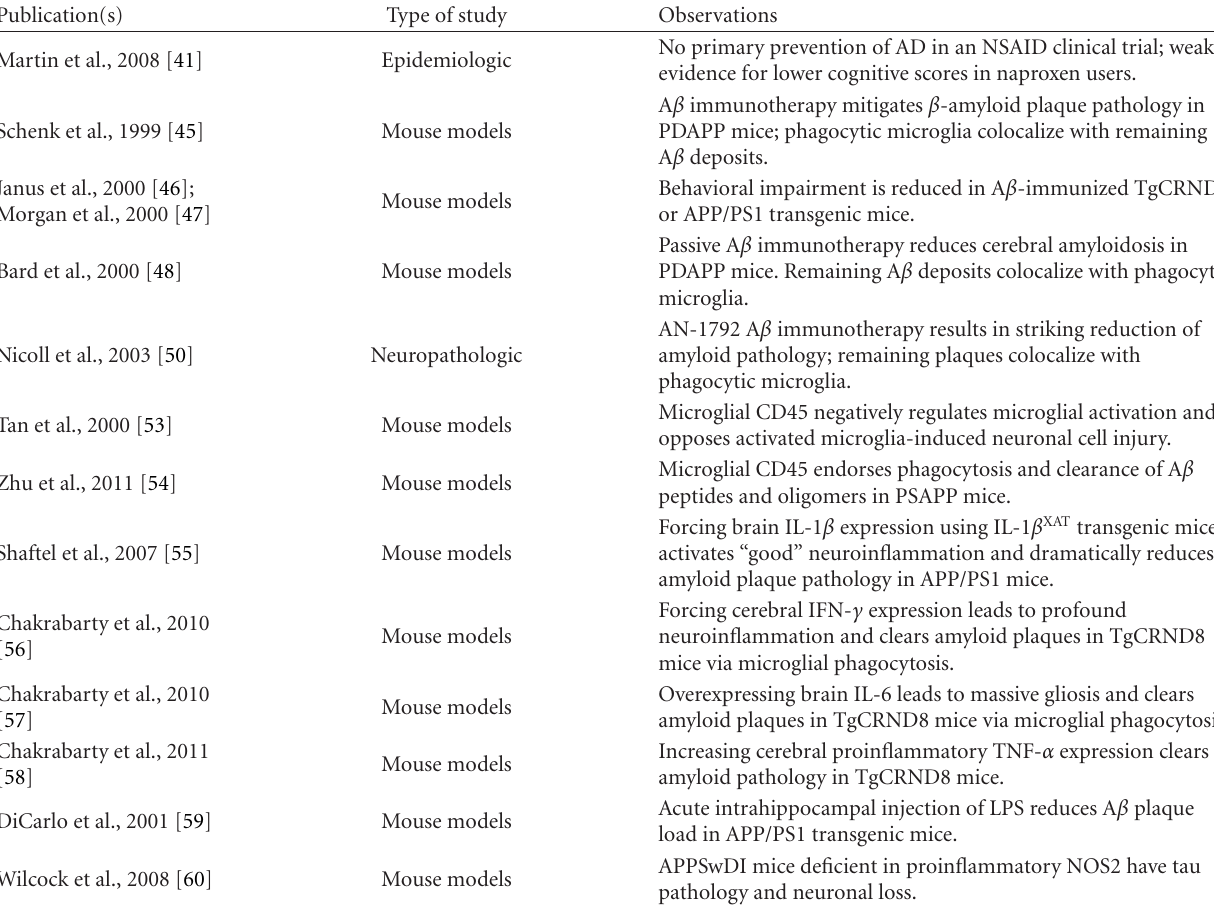
Table 2: “Good” microglia in Alzheimer